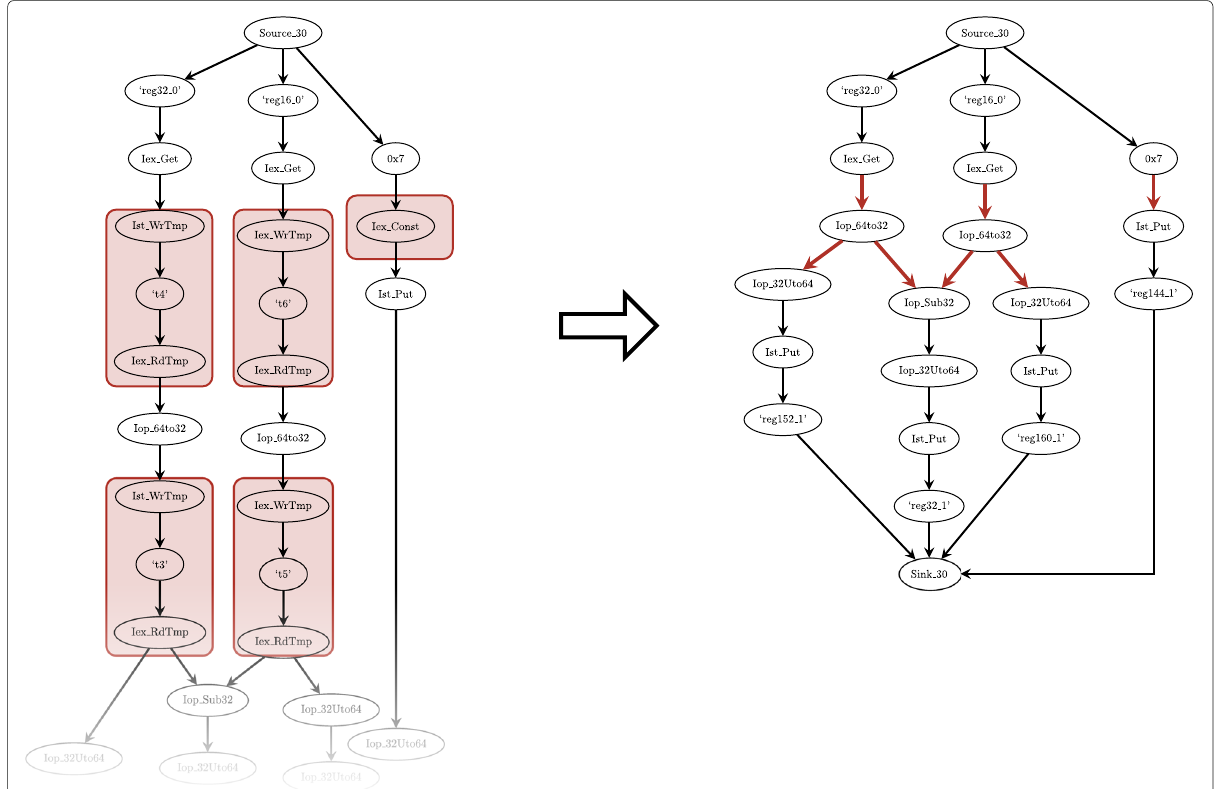
Fig. 3 Here we show how redundant instructions were removed to contract the graph. On the left the graph is shown before the contraction, and on the right it is demonstrated after the contraction